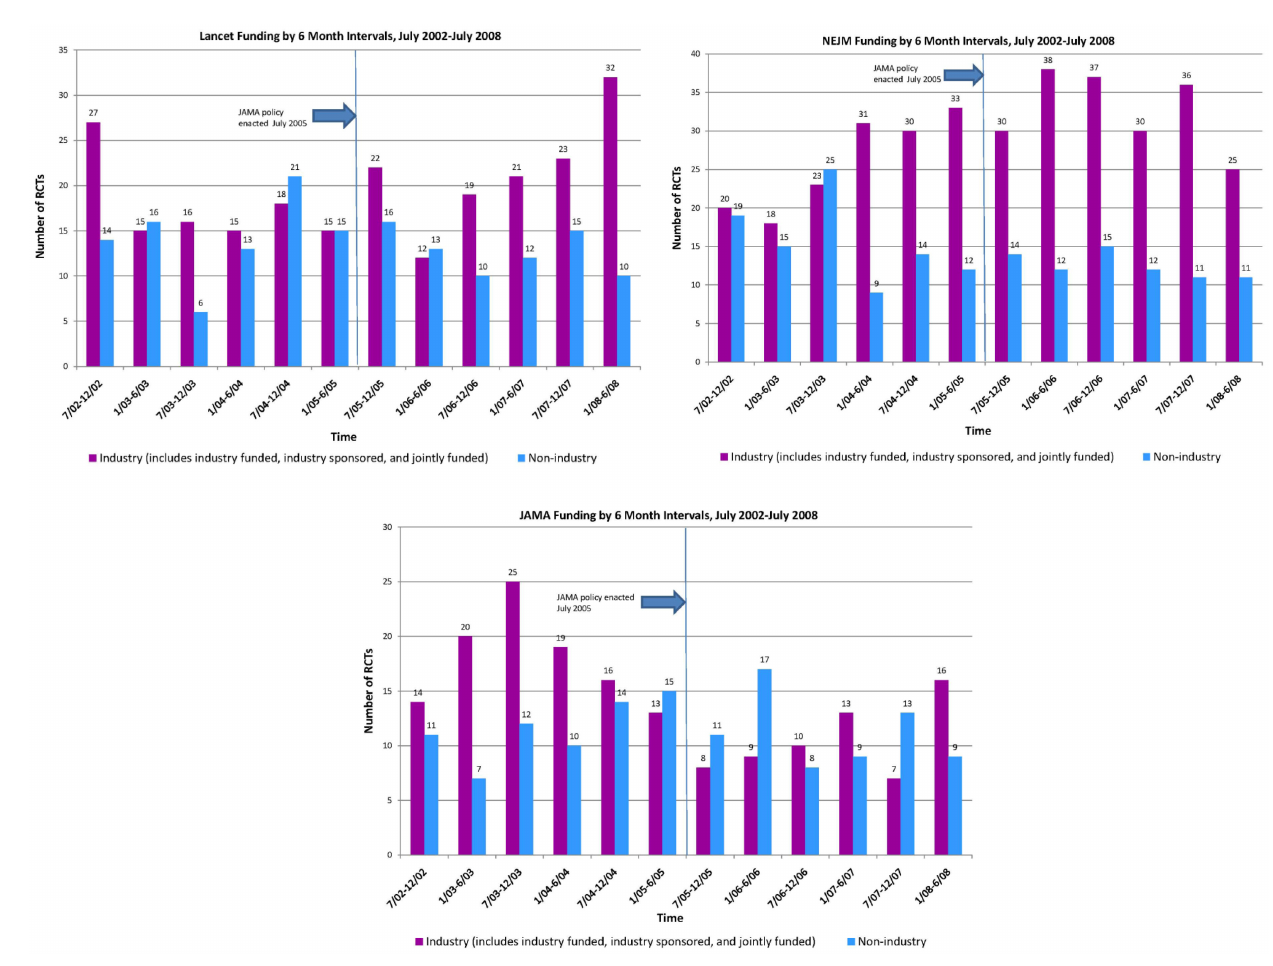
Figure 1. Number of randomized controlled trials published by (a) JAMA , (b) NEJM and (c) Lancet by funding source over time. ( JAMA introduced its policy for independent statistical analysis for industry-funded studies in July 2005.) ‘Industry’ funded trials includes those that were: solely industry funded; jointly funded by industry and non-commercial sources; or supported by the industry (i.e. the manufacturer provided materials